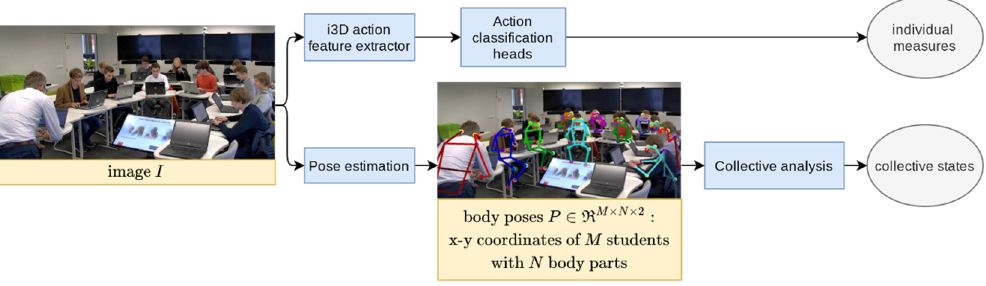
Figure 2. Data-processing pipeline for engagement estimation.